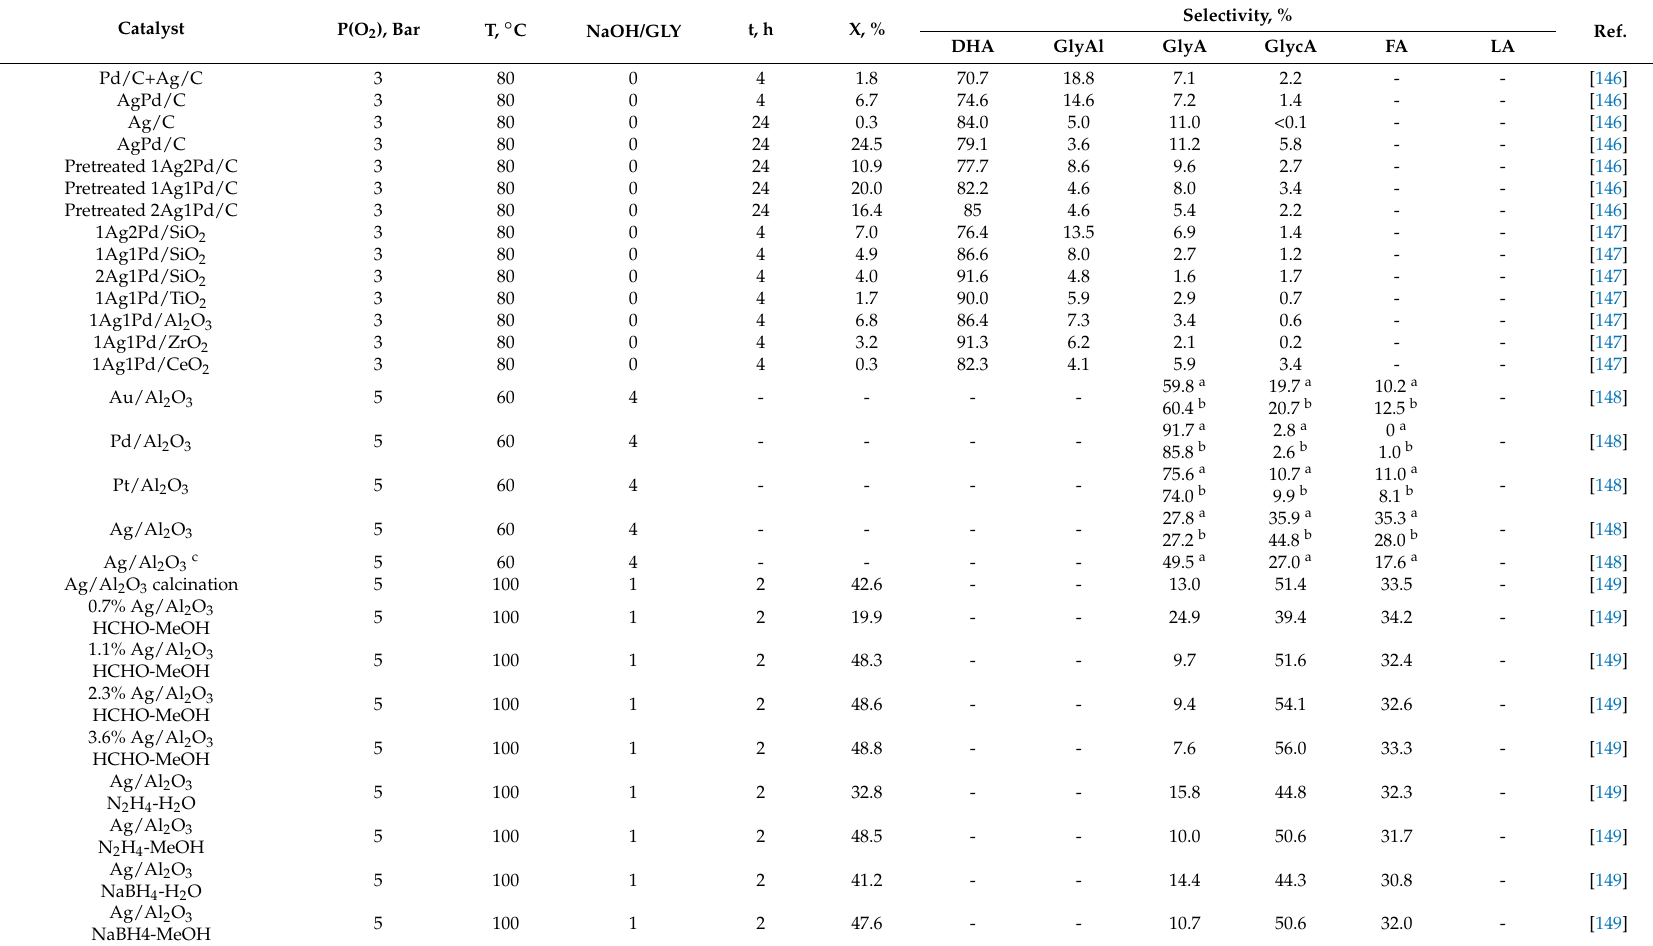
Table 6. Oxidation of glycerol over Ag-containing